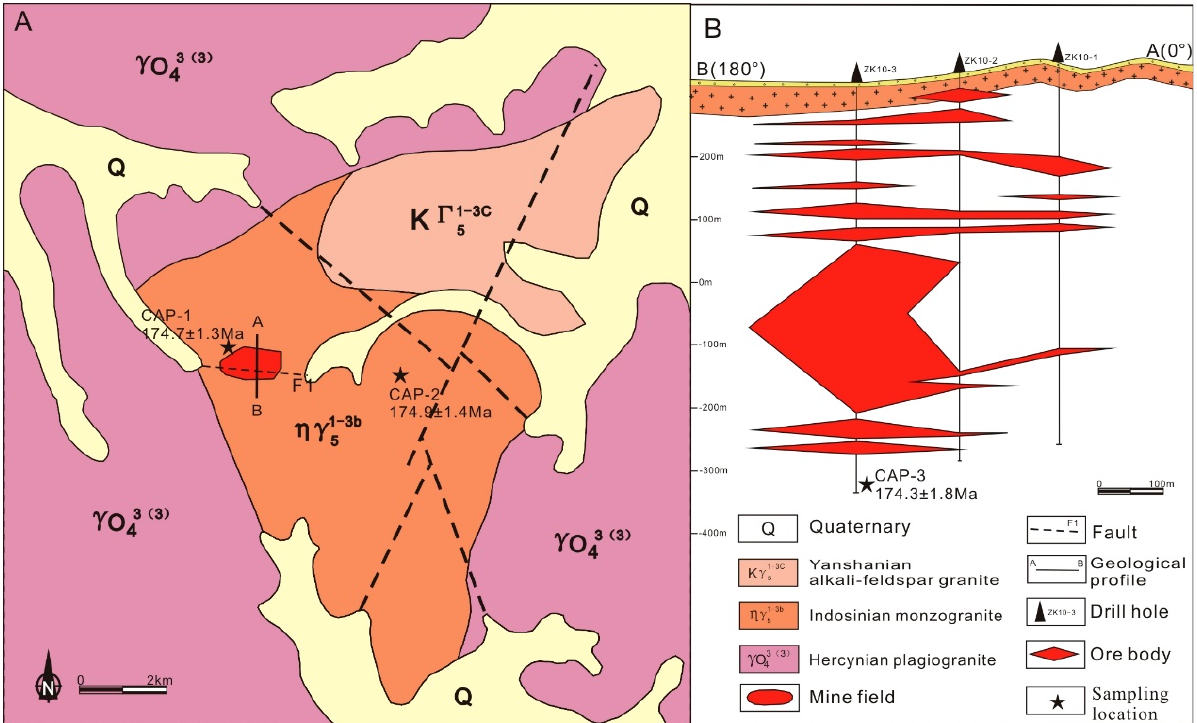
Figure 2. Regional geological and metallogenic map ( A ), and Exploration section map ( B ) in the Chang’anpu Mo deposit.